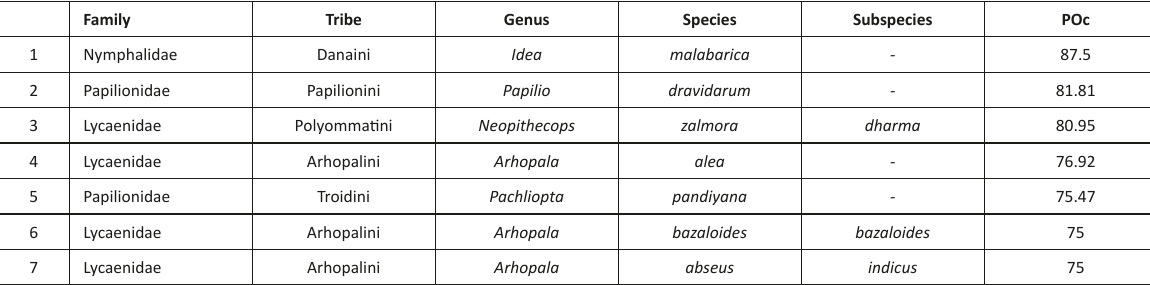
Table 1. Percentage of occurrence (POc) of myristica swamp dependent butterflies.